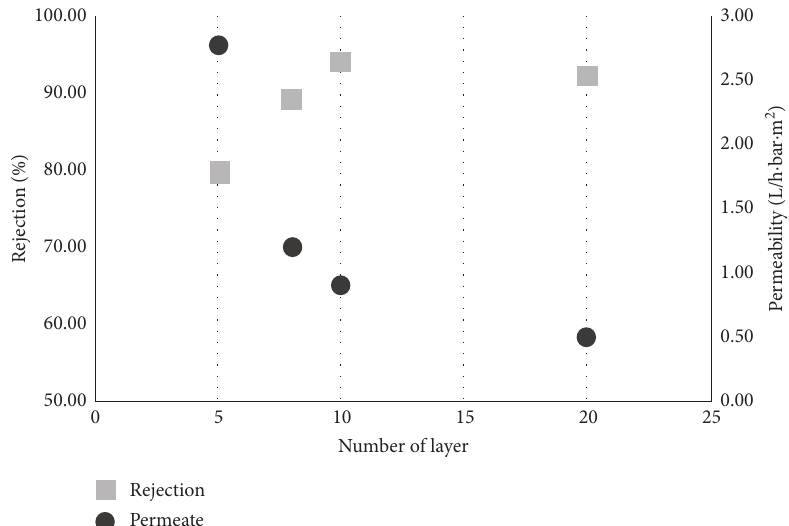
Figure 2: Effect of solution pH on performance of (PEI/PSS) concentration � 1345.6 ± 66.6ppm, and pH � 6.52 ± 0.06).